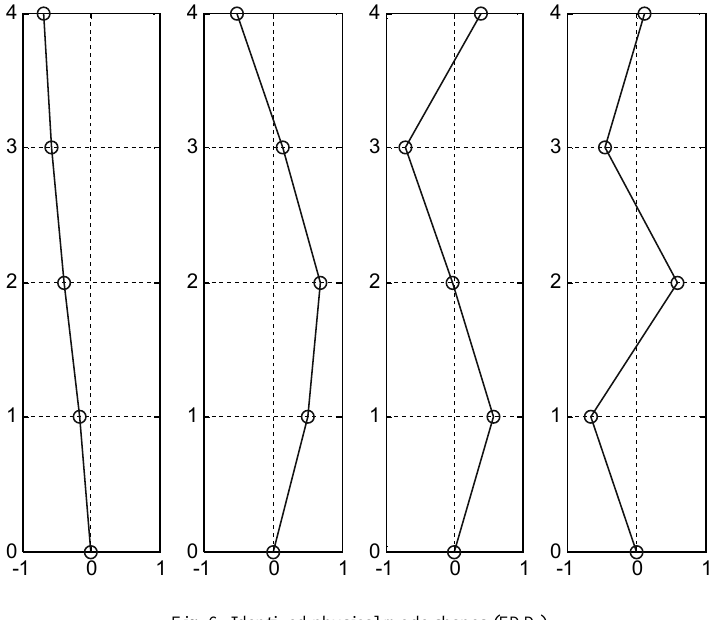
Fig. 6. Identified physical mode shapes